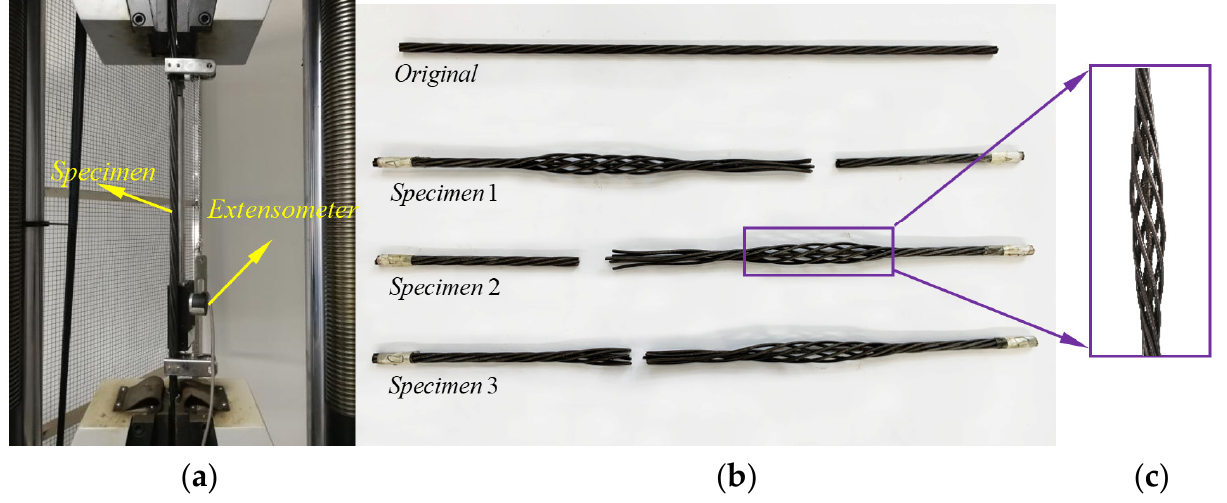
Figure 3. Standard tension test: ( a ) test machine; ( b ) failure pattern; ( c ) “birdcaging” knot.